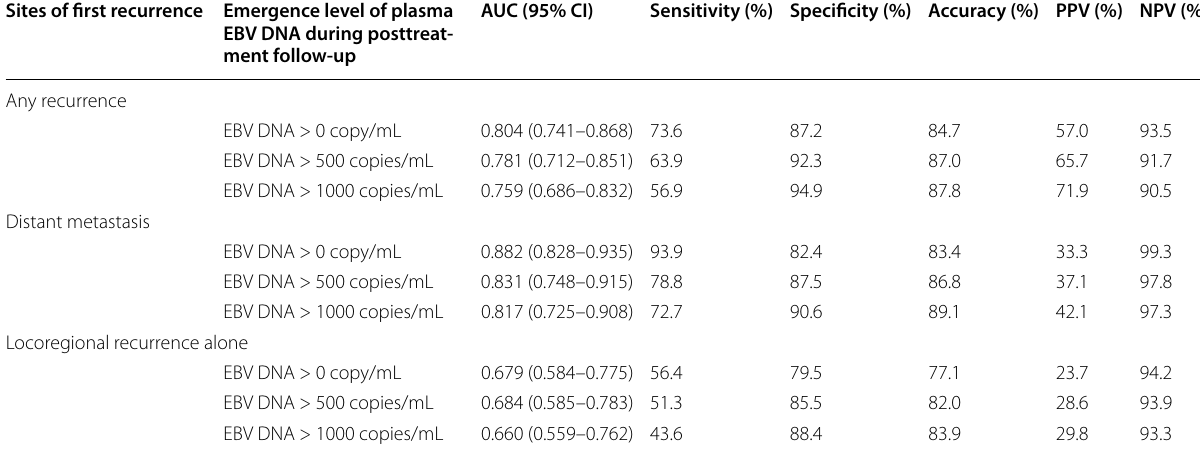
Table 4 Diagnostic value of plasma EBV DNA for predicting tumor recurrence in the 385 patients with NPC who were treated with